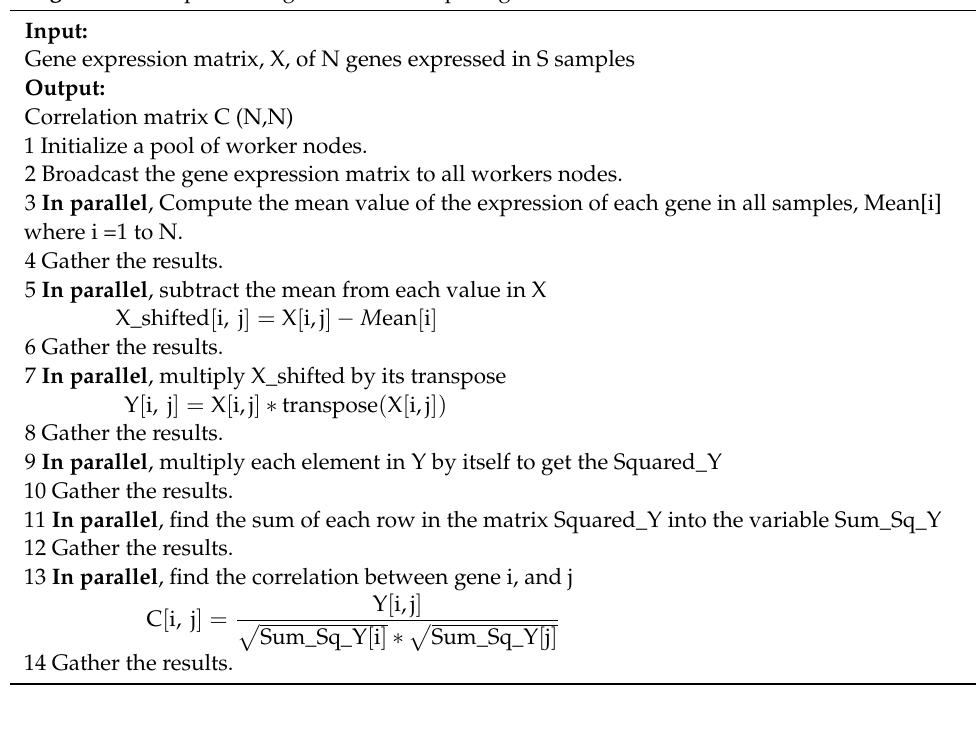
Algorithm 2: A parallel algorithm for computing the correlation